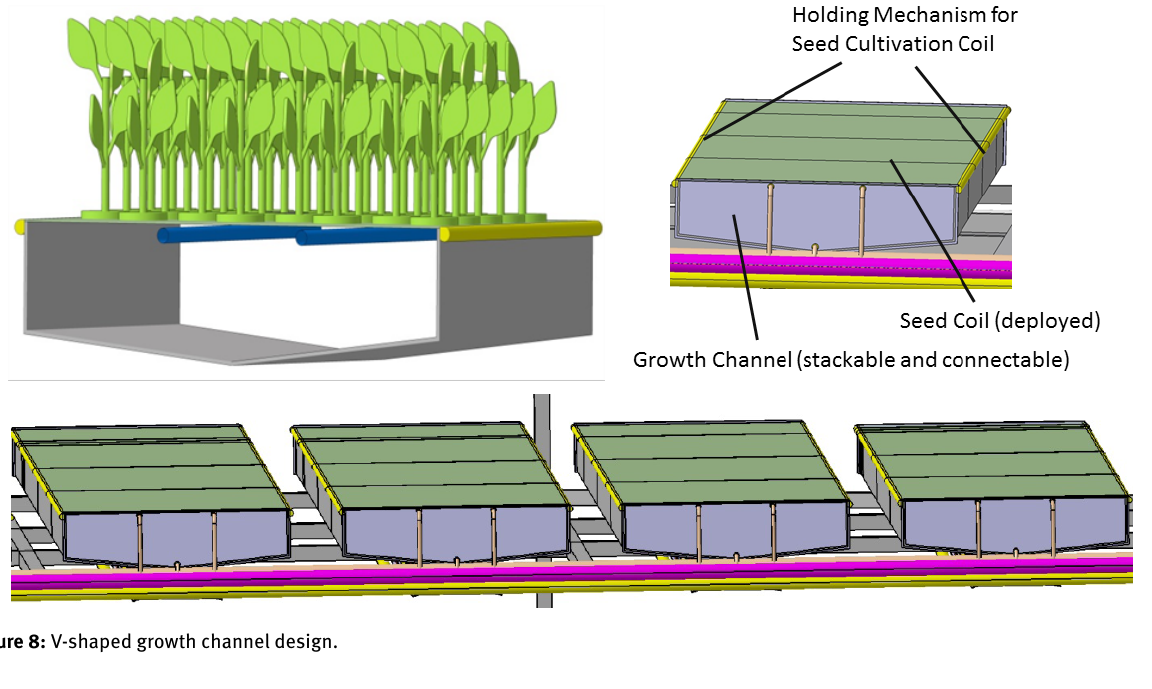
Figure 8: V-shaped growth channel design.